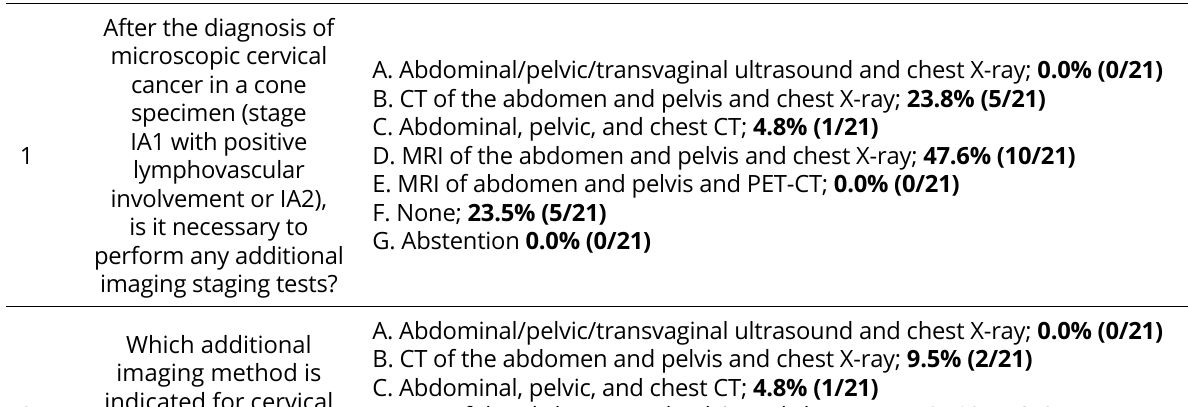
Key issues in the management of cervical cancer: consensus recommendations by a Brazilian expert panel Brazilian Journal of Oncology